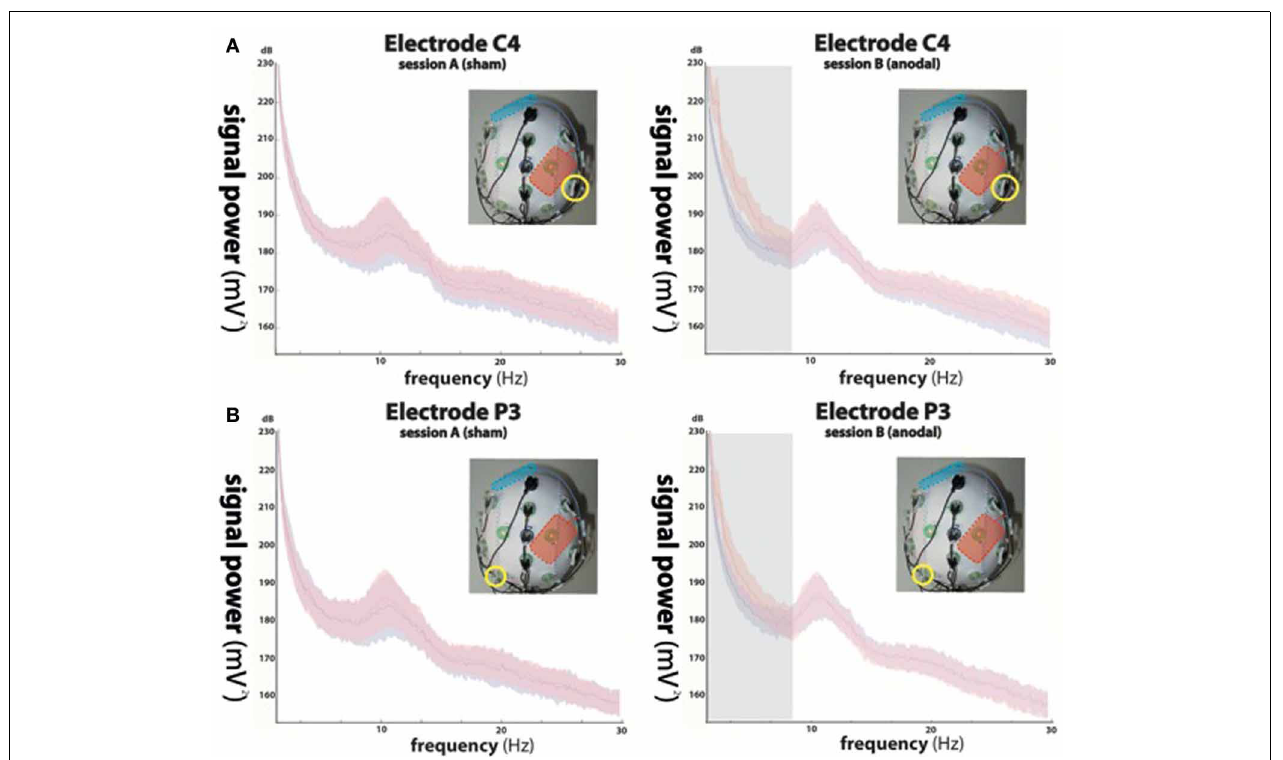
FIGURE 2 | Power spectra of the electroencephalographic (EEG) signals recorded from electrode C4 (A) indicated by yellow circles in the upper panels and P3 (B) during sham stimulation (left column, red curve) and anodal stimulation (right column, red curve). Power spectra of trials in absence of stimulation (block 1) are shown in blue. While not significant during sham stimulation (left column), anodal stimulation